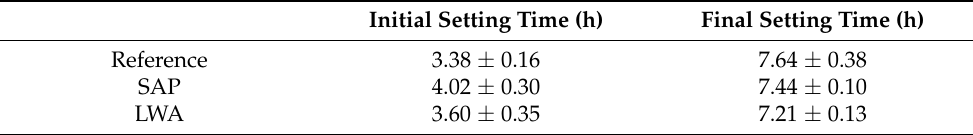
Table 4. Initial and final setting time of reference, SAP and LWA mortars, based on two replicates per mixture.